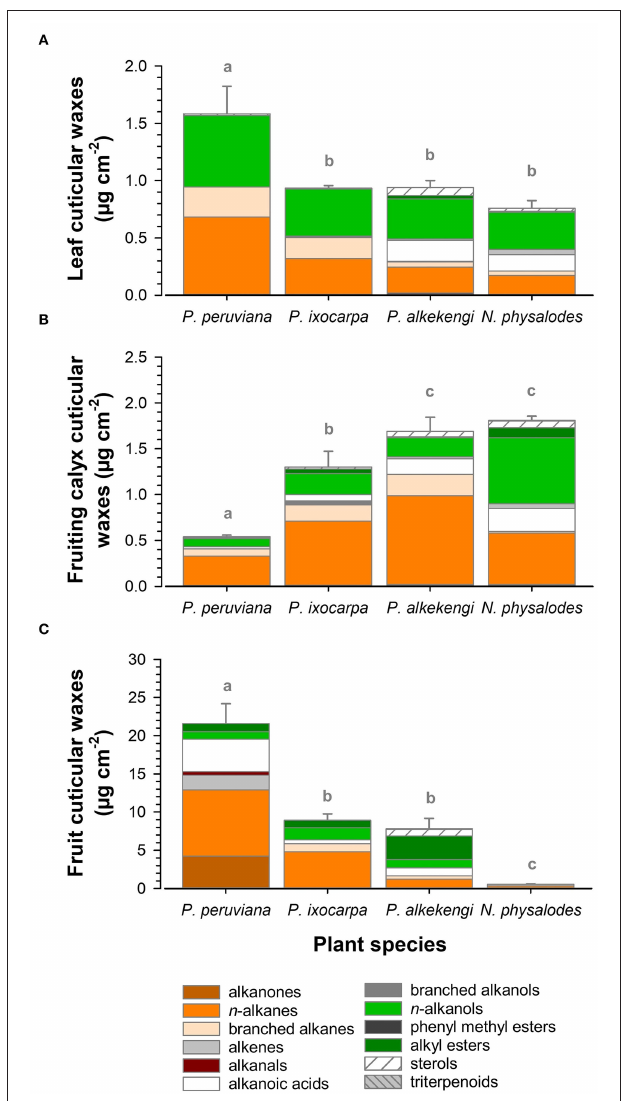
FIGURE 3 | Compositional analysis of cuticular wax load of fully expanded leaves (A) , fully inflated fruiting calyces (B) , and ripe fruits (C) of Physalis , Alkekengi, and Nicandra species subdivided into compound classes. Data are shown as mean ± SD ( n ≥ 4). Different letters indicate significant differences between plant species ( p <